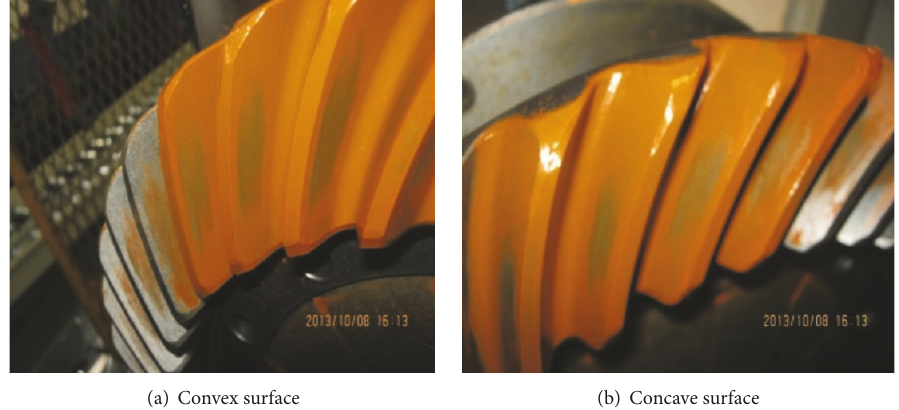
Figure 6: Tested contact pattern for original design parameters.